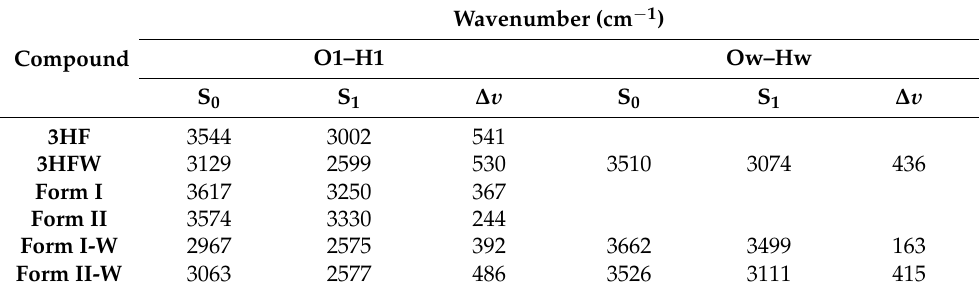
Table 2. A summary of the values of the O1–H1 and the Ow–Hw stretching vibrational modes of enol form for all compounds in both S 0 and S 1 states and their spectral shifts ( ∆ υ in cm − 1 ). Wavenumber (cm − 1 ) O1–H1 Ow–Hw Compound S 0 S 1 ∆ υ S 0 S 1 ∆ υ 3HF 3544 3002 541 3HFW 3129